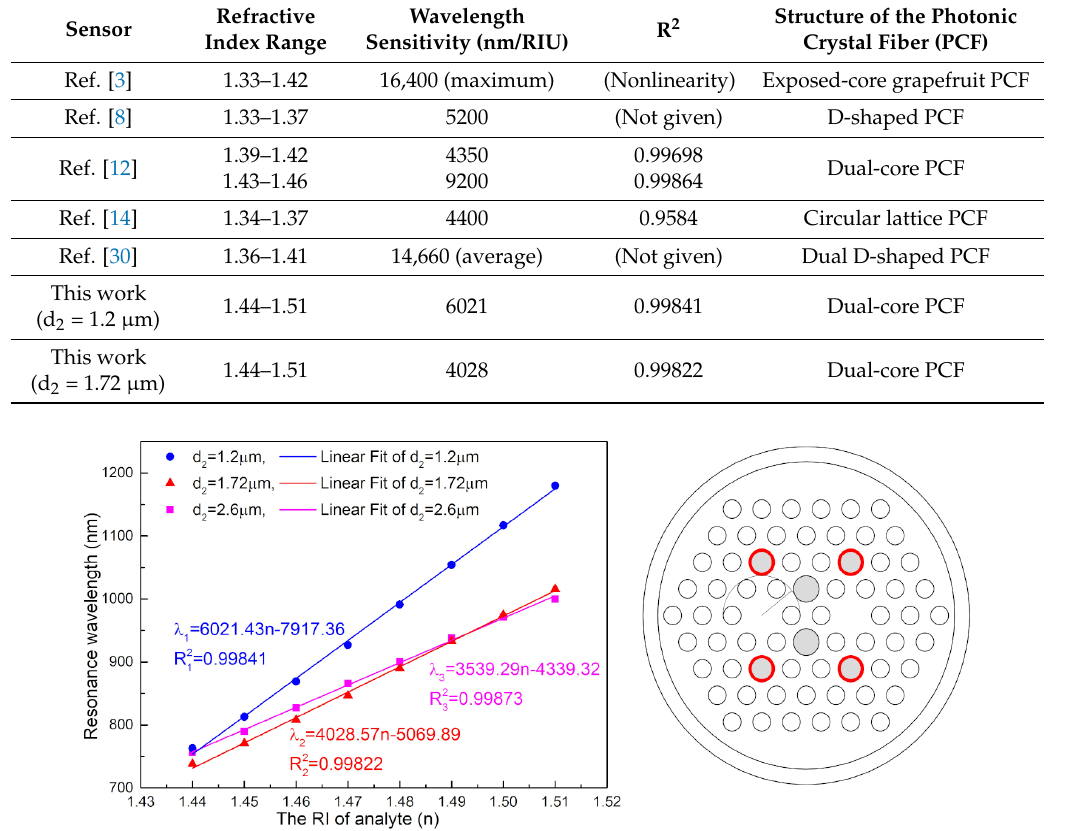
Figure 8. ( Left ): Resonance wavelength with n varying from 1.44 to 1.51; ( Right ): Structure of the improved sensor.